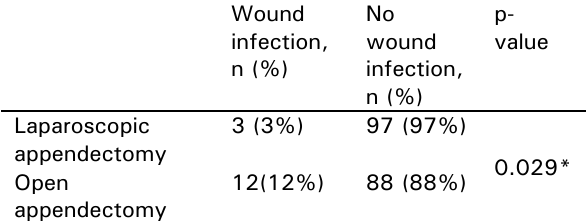
Table 4: Comparison of wound